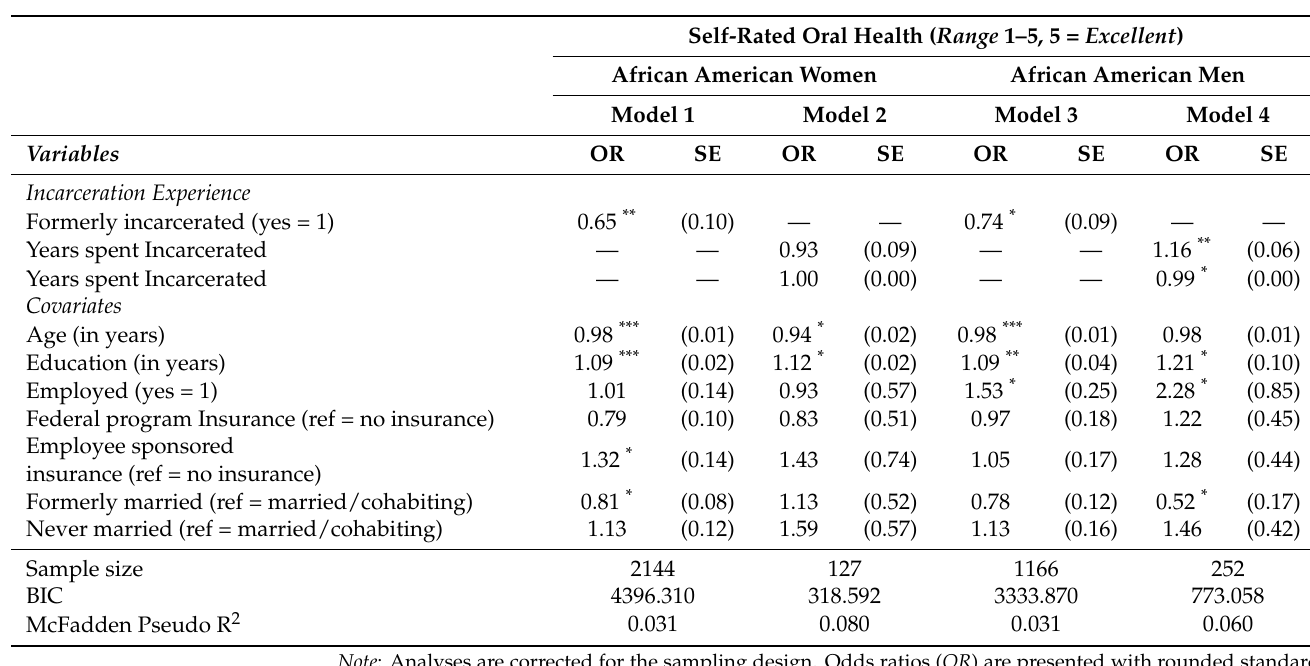
Table 2. Ordered logistic regression models predicting oral health for African American women and men in the National Survey of American Life, 2003.